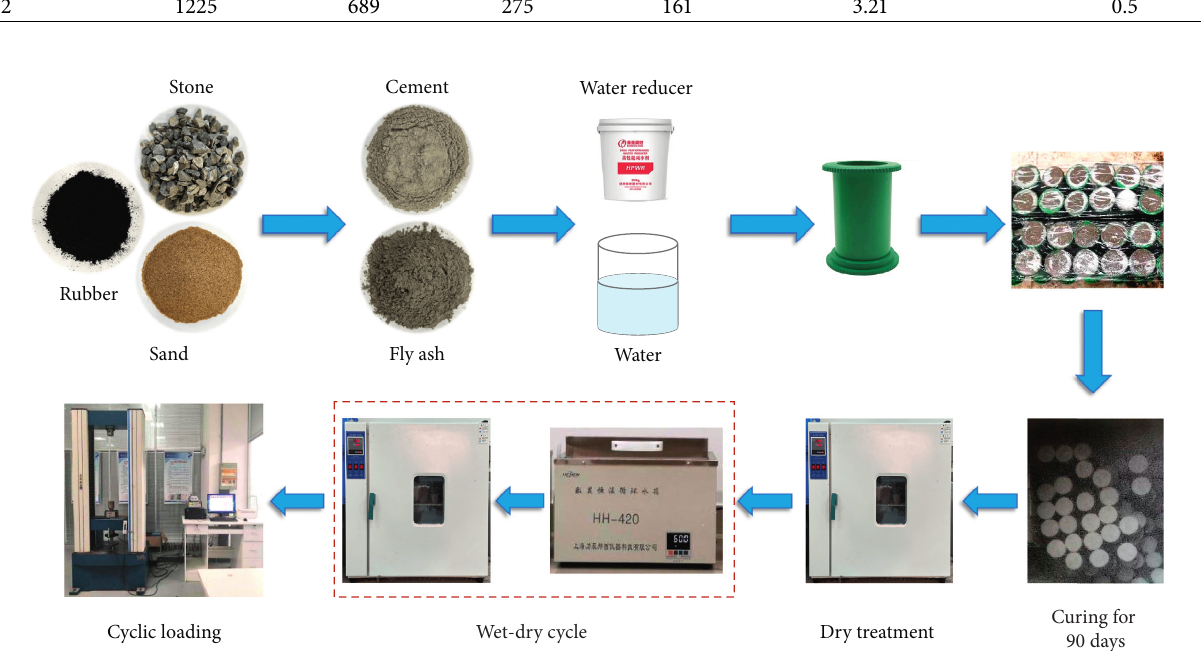
Figure 2: Details of test